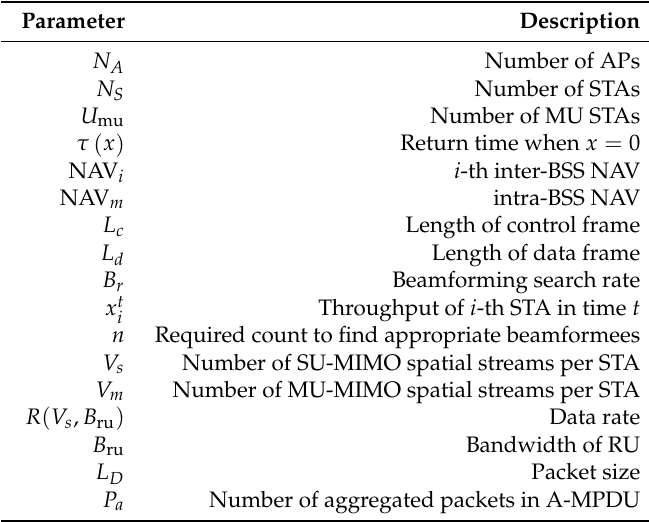
Table 3. Parameters used in